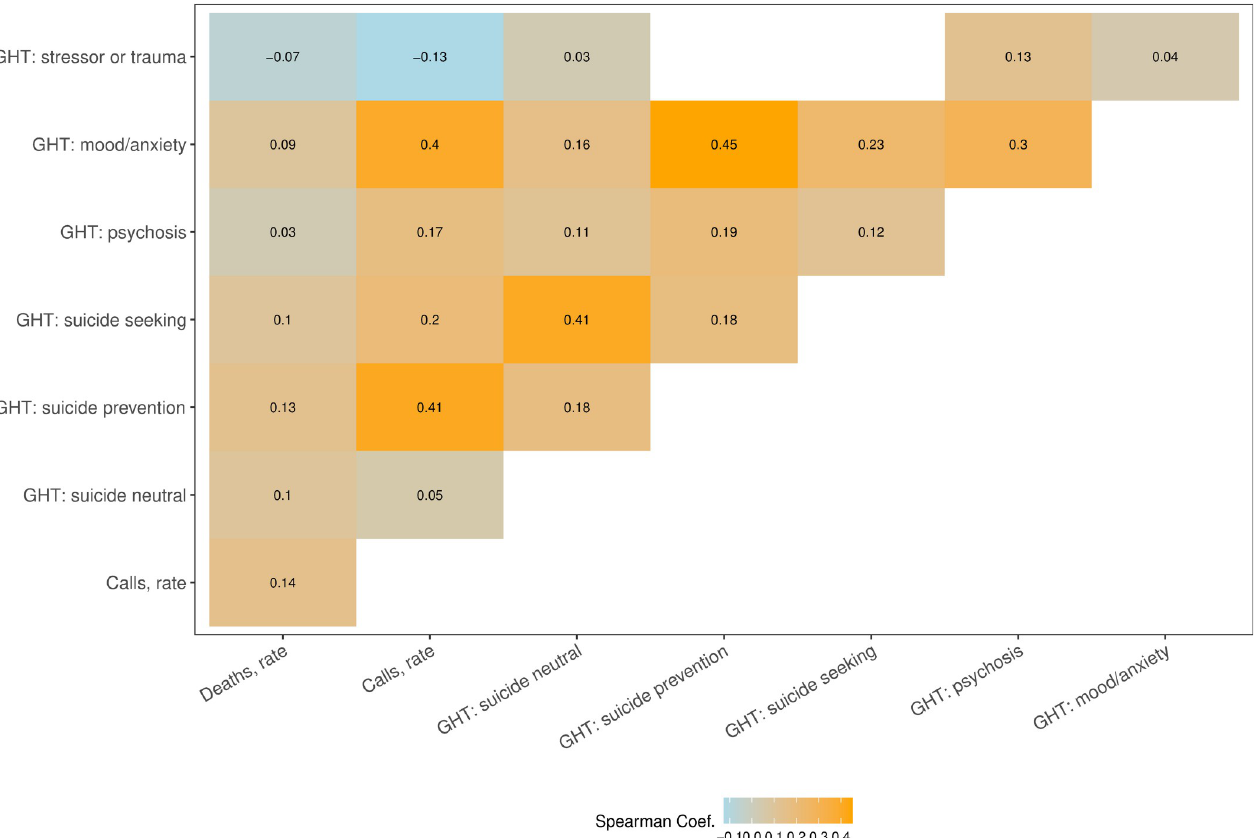
Fig 1. Pairwise Spearman correlation for each pair of variables. Correlations found to be not significant ( p > .05) are not shown.